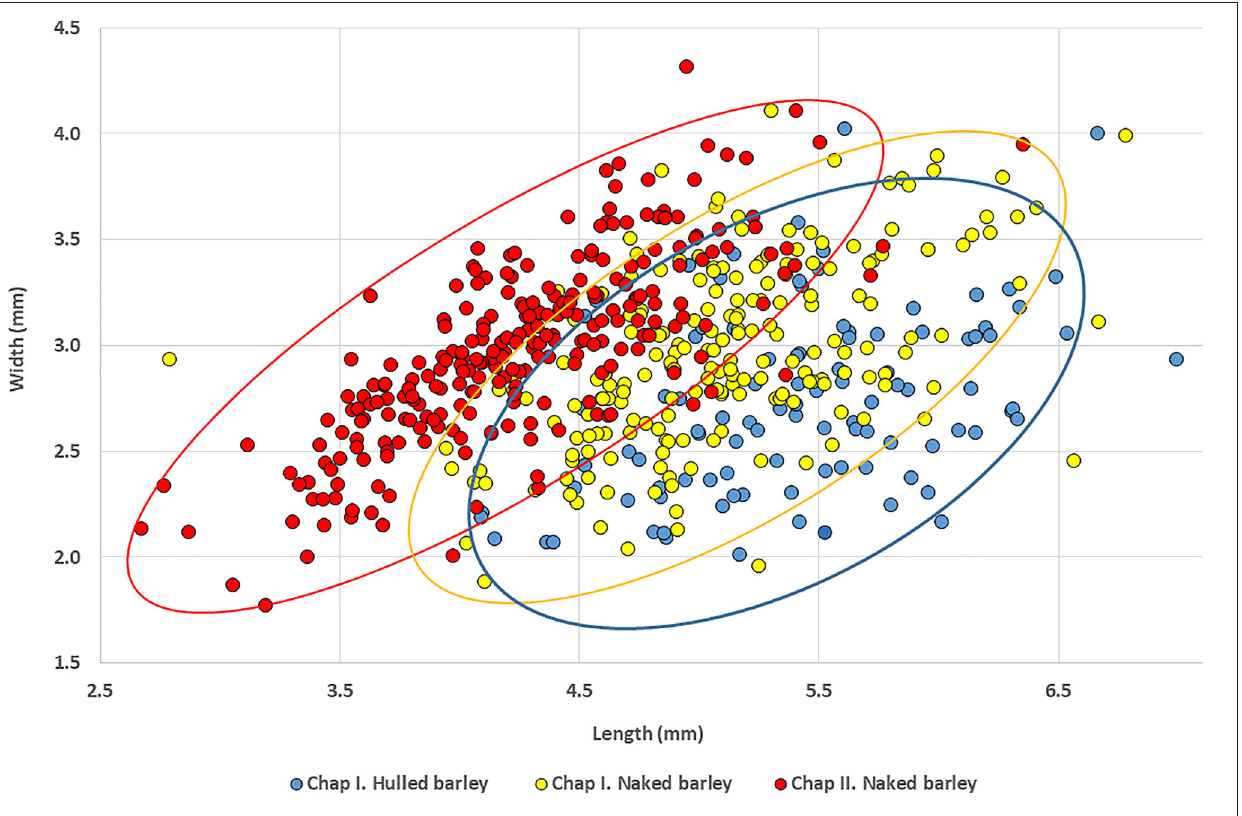
FIGURE 2 | A scatter plot based on barley measurements from two Chap phases.